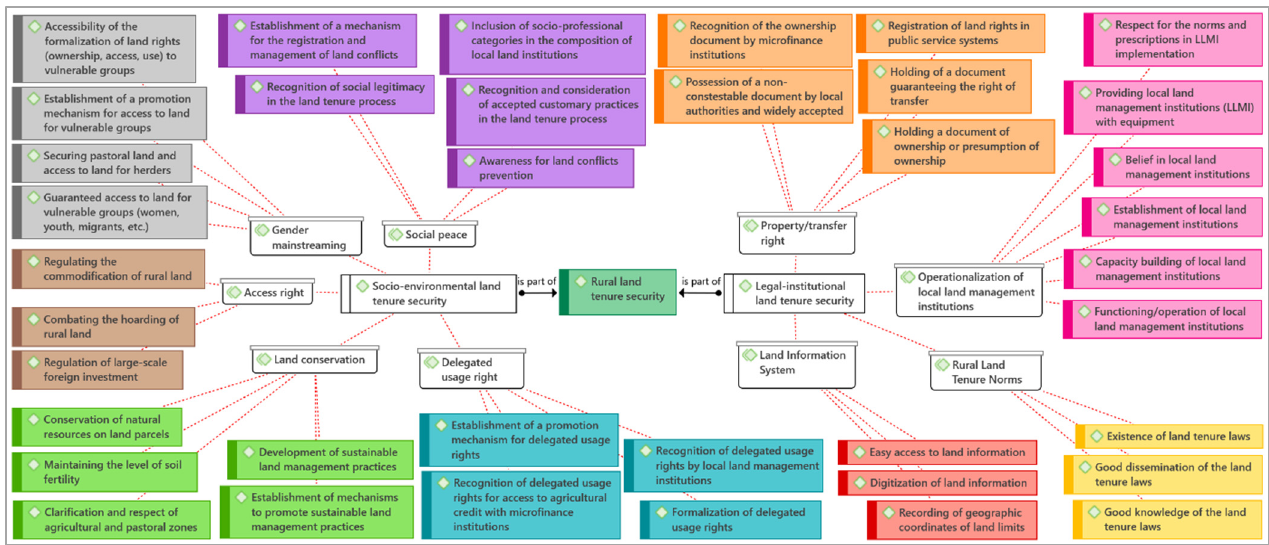
Figure 2. Main factors/dimensions of rural land tenure security according to